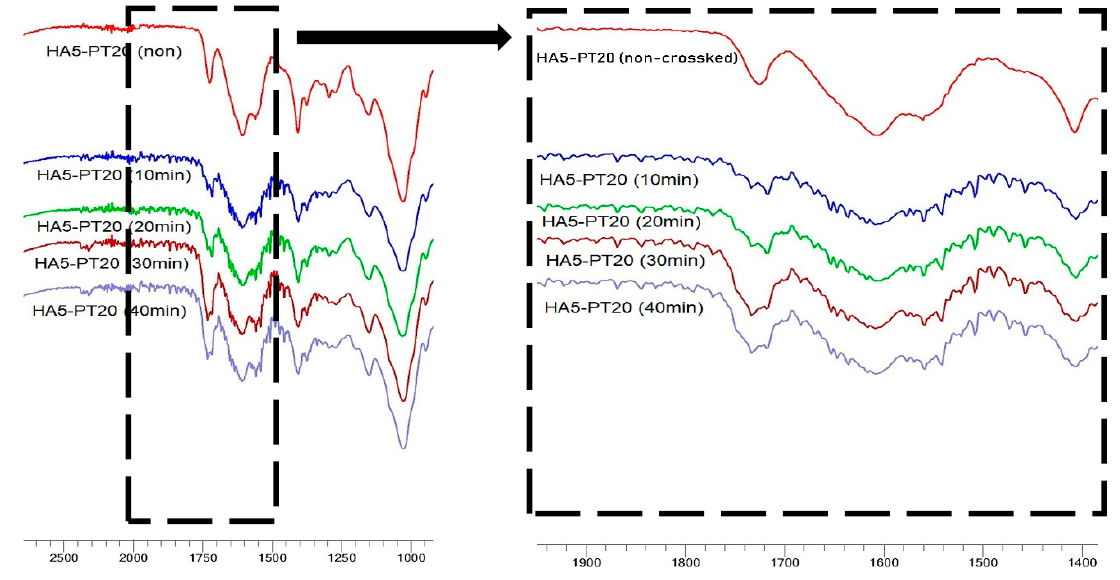
Figure 6. HA5-PT30 crosslinked by UV irradiation (x-axis is the wavenumber/cm − 1 ).